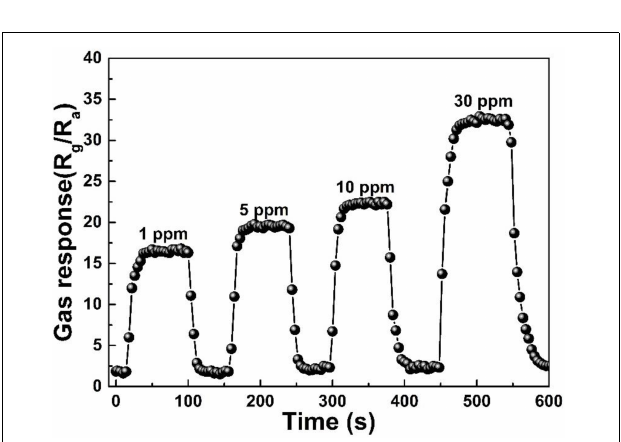
FIGURE 7 | Gas responses of flake-flower NiO based gas sensor toward different concentration of CO from 1 to 100 ppm at the optimal working temperature of 250 ◦ C.